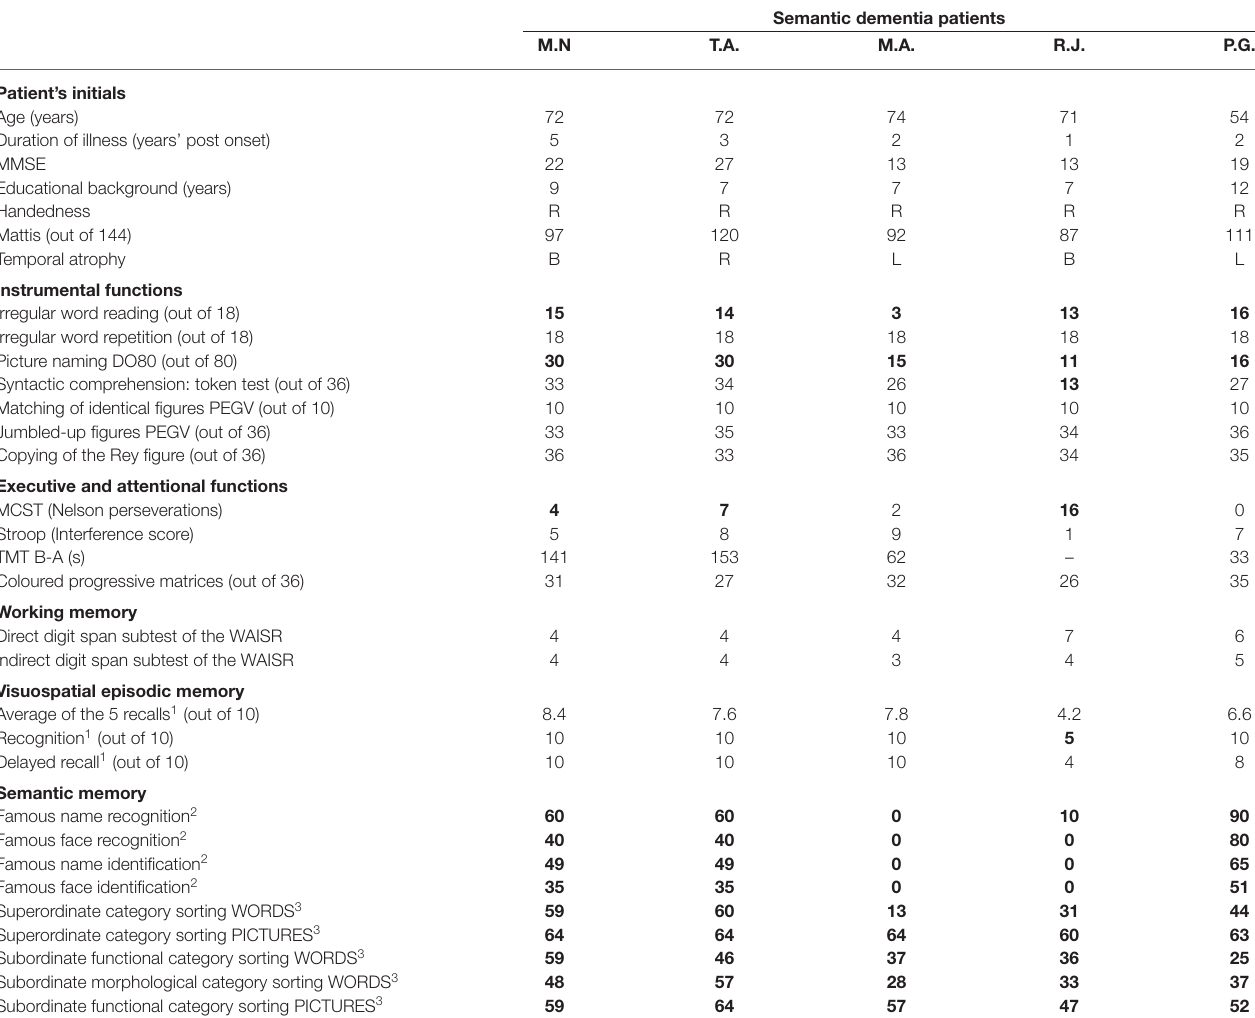
TABLE 1 | Clinical, demographic, and neuropsychological data of each semantic dementia